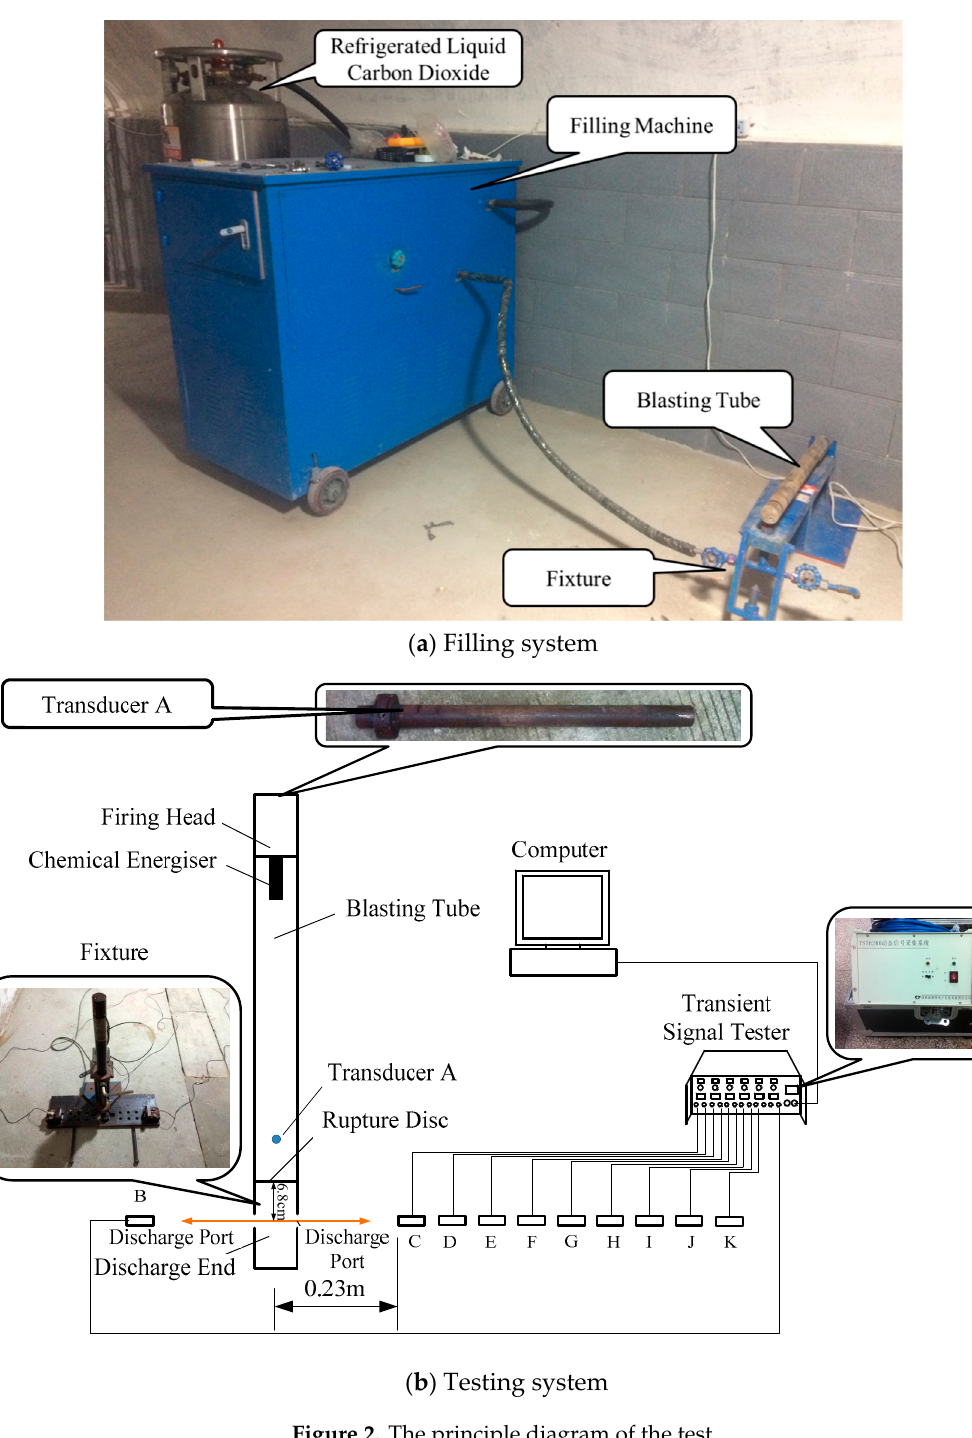
Figure 2. The principle diagram of the test.